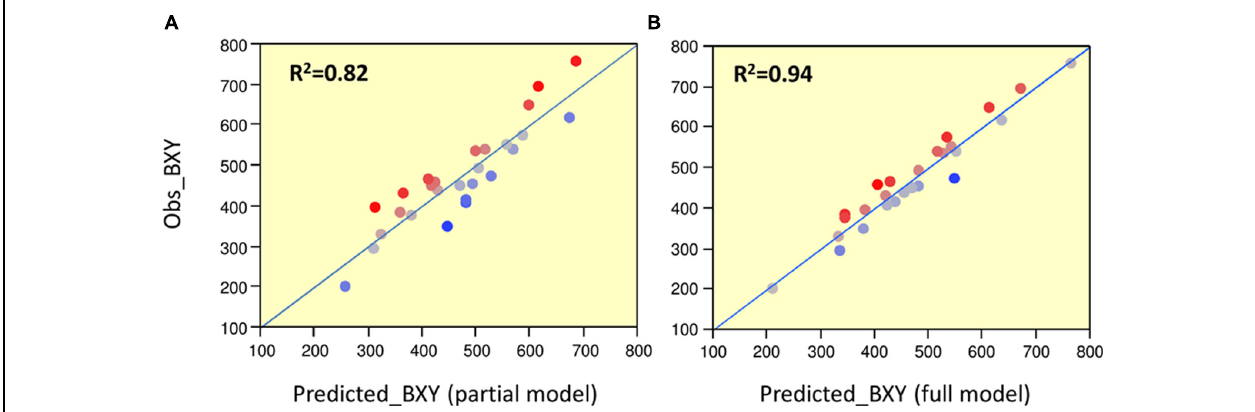
FIGURE 6 | Predicted vs. observed BXY for partial and complete models. Regressions of predicted vs. observed BXY values for the 27 ‘immortalized F2’ genotypes. (A) Partial model: predicted values were calculated based on model with main effects alone. (B) Full model: predicted values were calculated based on model with main effects + QTL by QTL interactions. The Red-to-Blue scale reflects the deviation from the predicted regression line.